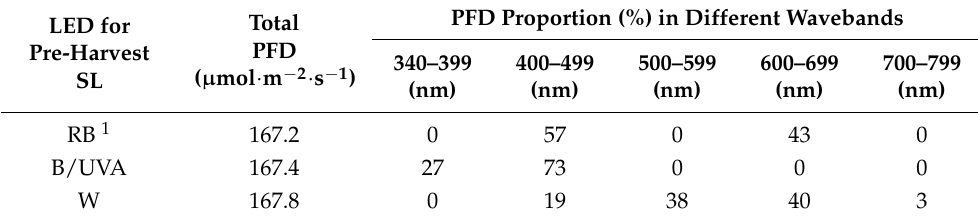
Figure 2. The spectral distribution of red and blue (RB) ( A ), blue/ultraviolet-A (B/UVA) ( B ), or white (W) ( C ) LEDs used for pre-harvest supplemental lighting. Table 2. Total and individual waveband photon flux density (PFD) of the three commercial LED lights used for pre-harvest supplemental lighting (SL).